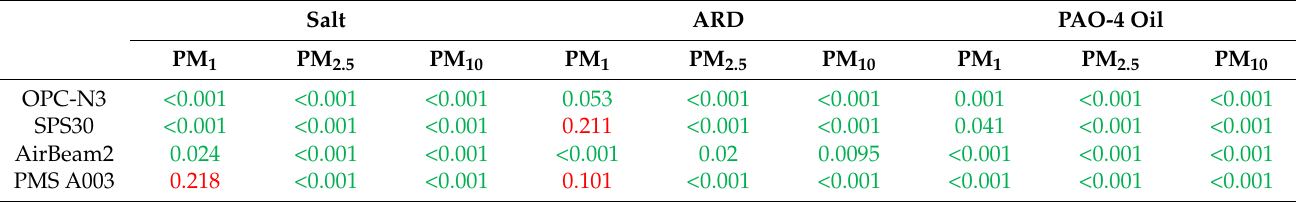
Table 4. Results of the t -test to compare slopes for environmental and occupational